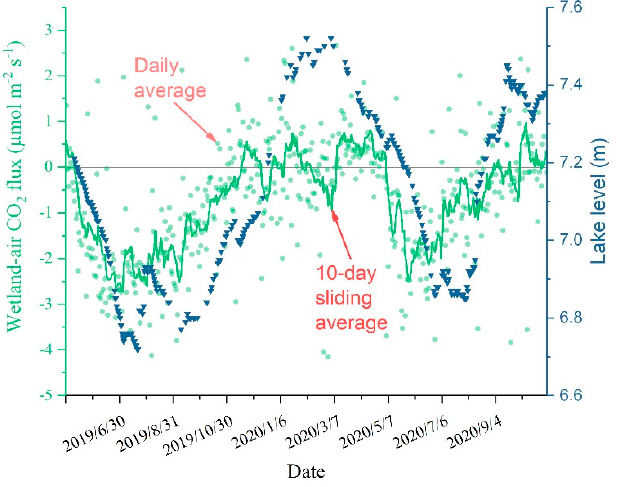
Figure 1. The location of the BYDL and the LI-COR 7500 eddy covariance analysis system for monitoring the meteorology and the wetland-air CO 2 exchange fluxes.